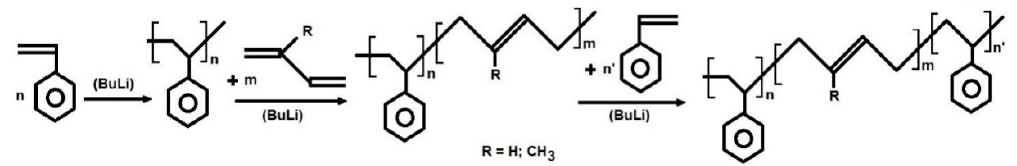
Figure 1. Synthesis of Styrene-butadiene (SBS) (R = H) and styrene-isoprene (SIS) (R = CH 3 ) block copolymers by living polymerization.